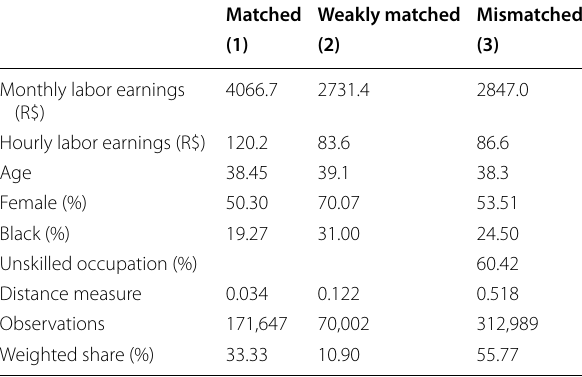
Table 1 Summary statistics of individuals in the sample. Source: the 2010 Brazilian